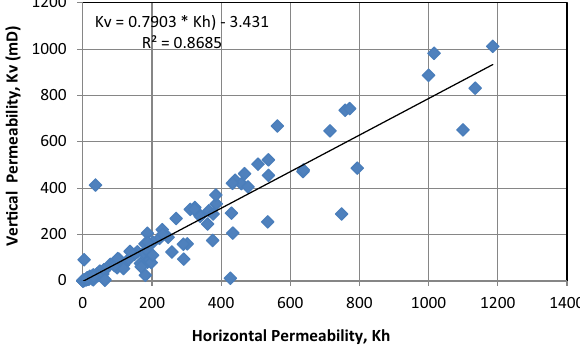
Kv = 0.7903 * Kh) - 3.431 R² = 0.8685